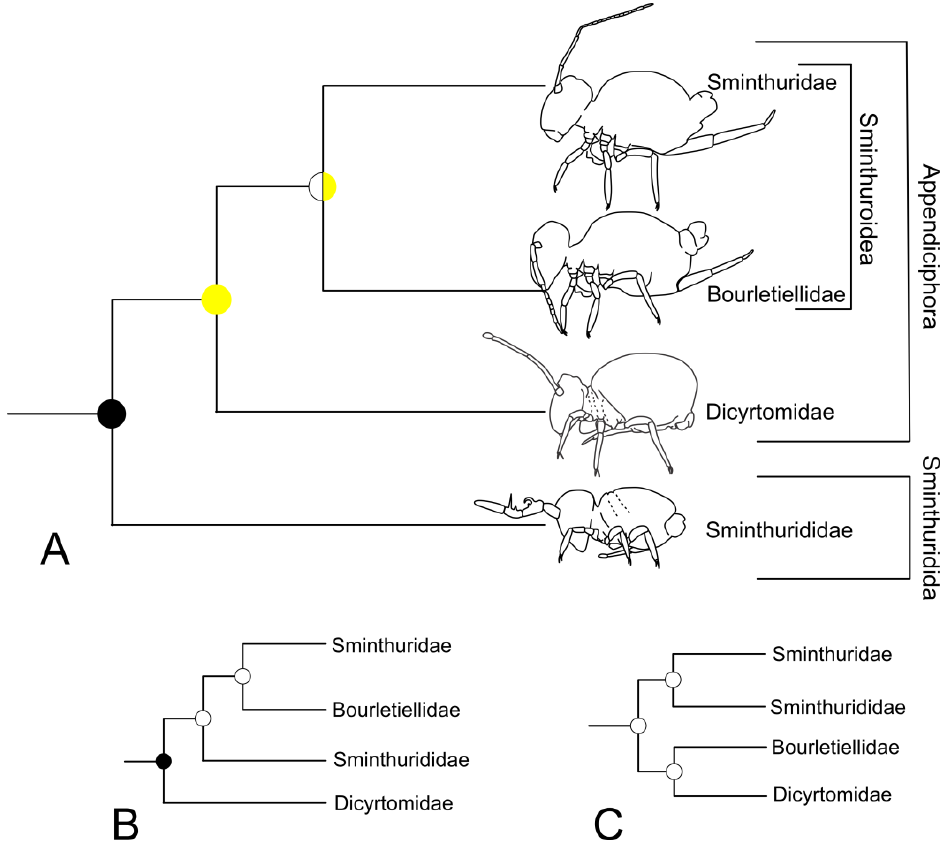
Figure 5. Summarized phylogenetic relationships of the higher Symphypleona: ( A ) topology of ML_1, ML_2, ML_3 and ML_4 trees (nodes depict only ML_1 support levels); ( B ) topology of BI tree; ( C ) topology of MP tree. Node circles represent SH-aLRT support (left side) and bootstrap values (right side), respectively, for ML tree, posterior probability for BI tree, and maximum parsimony bootstrap for MP tree. Colors represent the following scores: black = 100 (1 for BI); yellow = 95 – 99.9 (0.95 – 0.99 for BI); grey = 90 – 94.9 (0.9 – 0.94 for BI); white < 90 (<0.9 for BI).